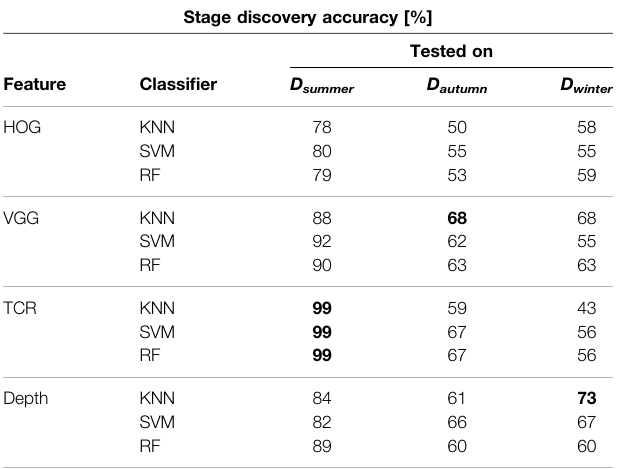
TABLE 1 | Stage discovery accuracy trained on D summer . Two stages. We used repeated 2-fold cross-validation, i.e., 50% of data was selected for training and 50% for testing which was repeated fi ve times. Highest accuracy for each season marked in bold.